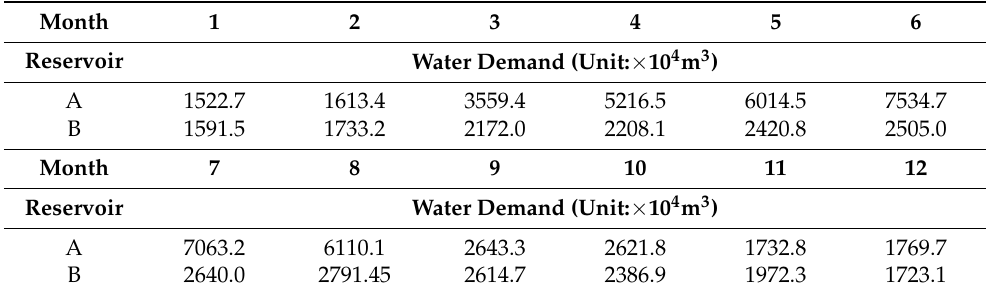
Table 4. Outflow volumes of A and B reservoirs solved by PSO-CSA algorithm.